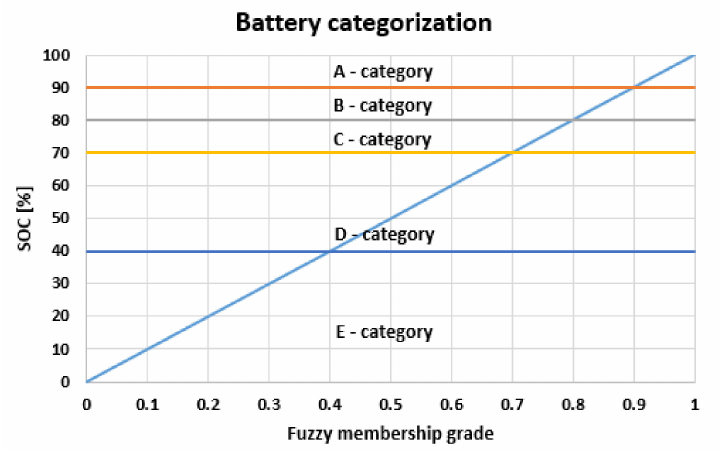
Figure 4. Categorized battery